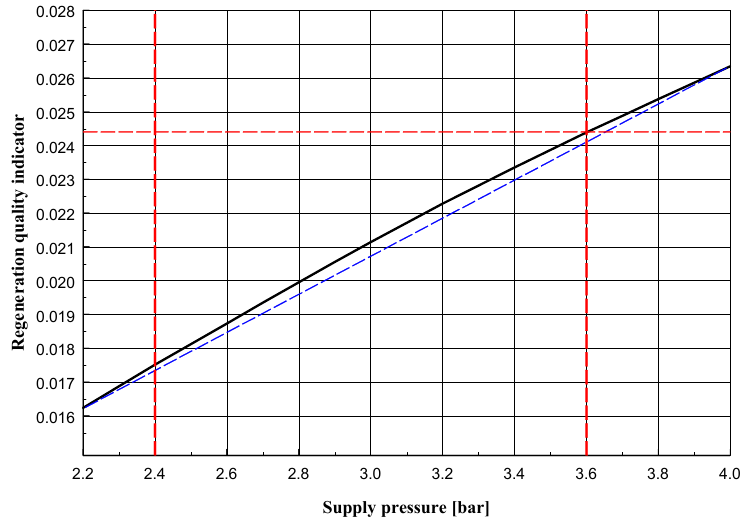
Figure 15. Regeneration quality indicator depending on pressure in supply line for h = 5 mm.